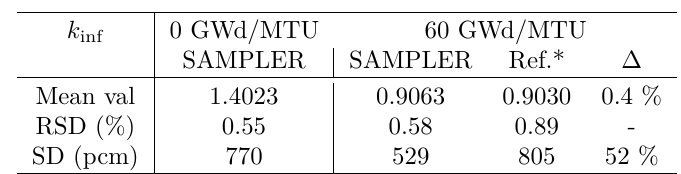
Table 2. Initial condition and final burnup uncertainties in k (using 56groupcov).